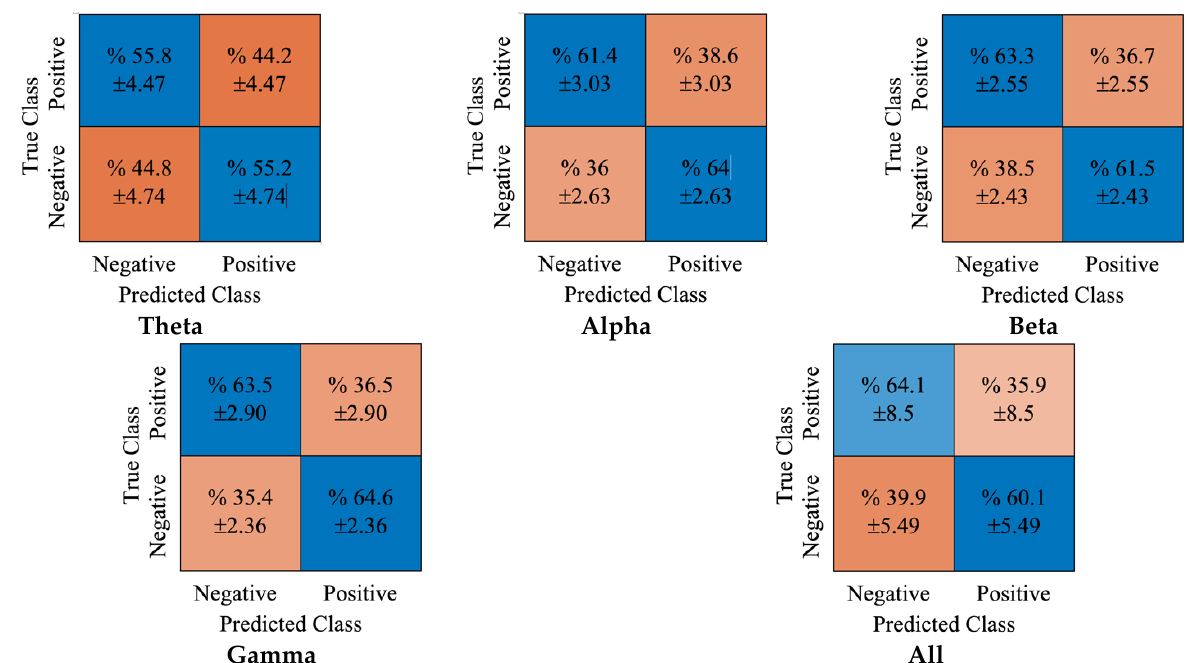
Figure 9. The obtained confusion matrices for DE features and LR classifier.